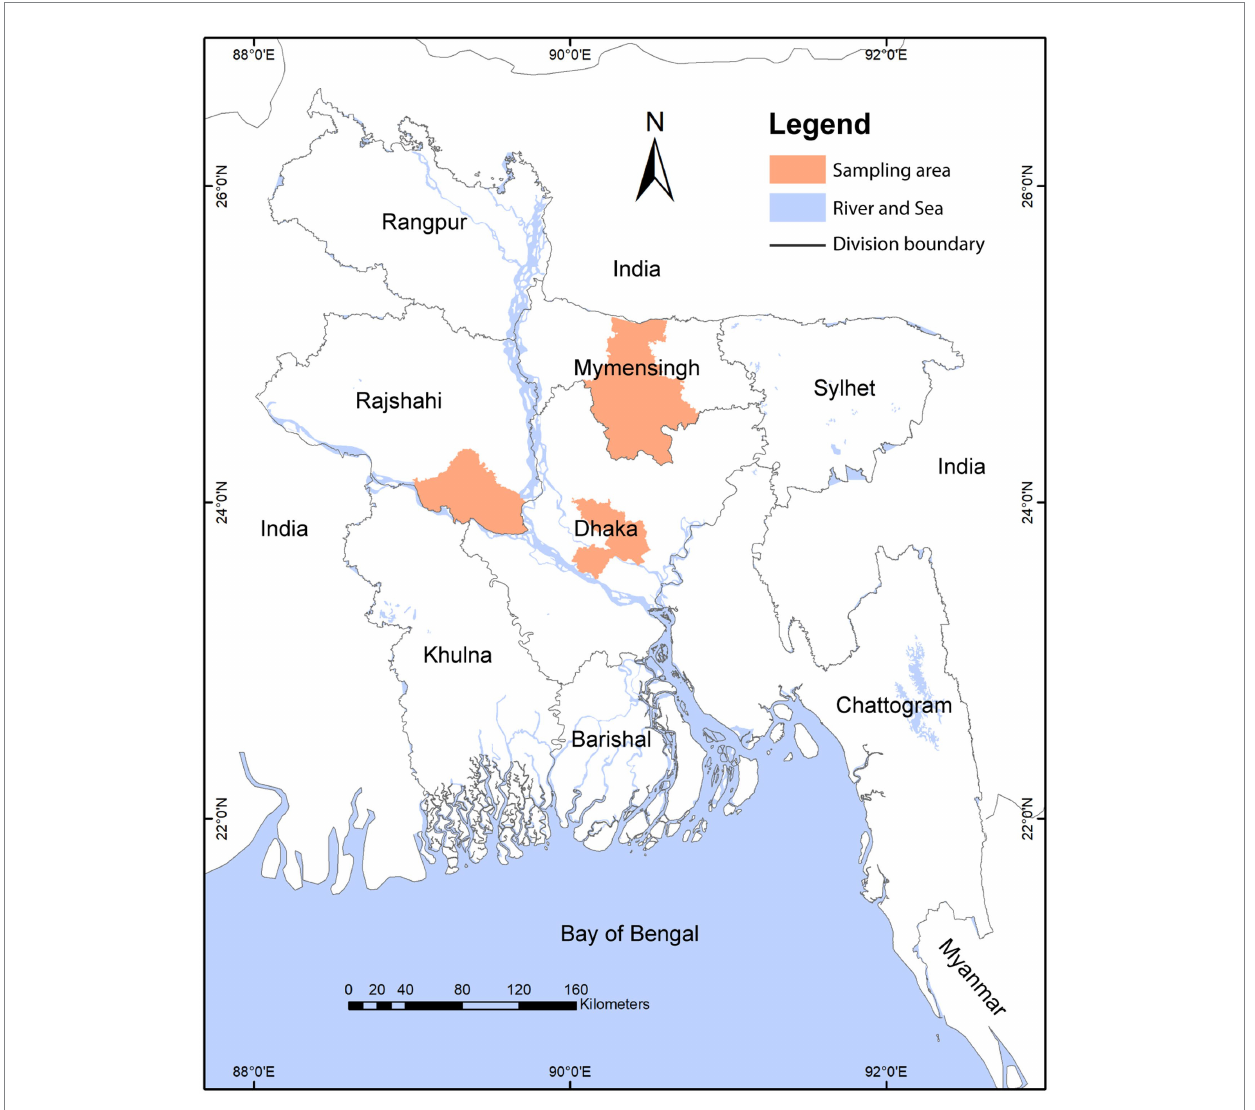
FIGURE 1 Map showing the study sites. Colored regions indicates the sampling districts of the